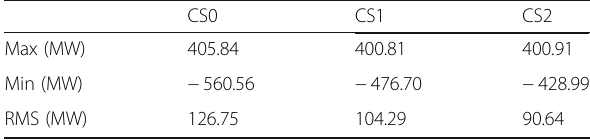
Table 5 Power output reduction of generating unit